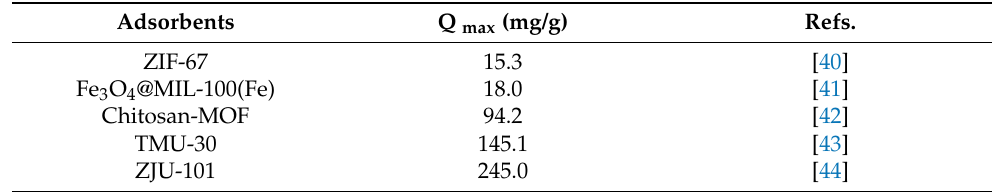
Table 4. Comparison of adsorption capacity for Cr(VI) ions in water